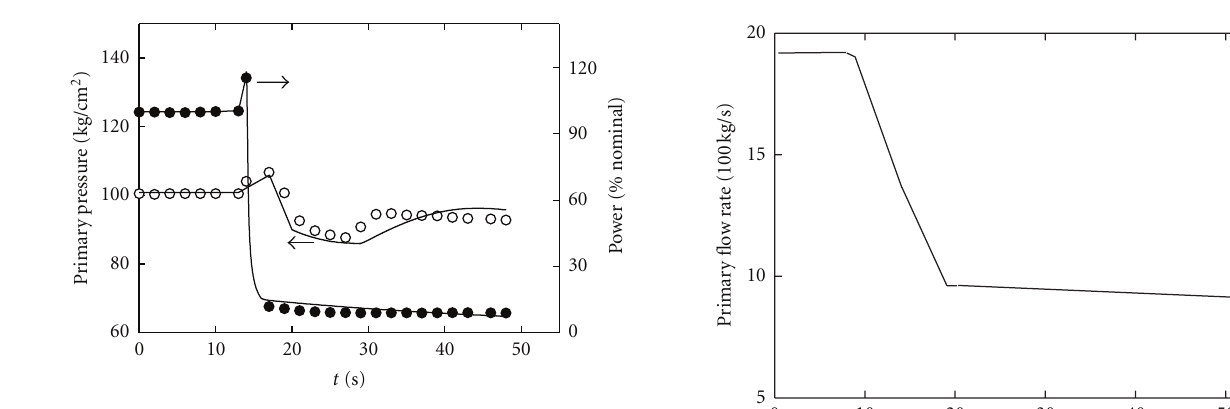
Figure 3: Event 1. Reactor power ( • ) and primary pressure ( ◦ ) responses to a positive reactivity injection and the loss of two primary pumps. The curves correspond to the simulation results.